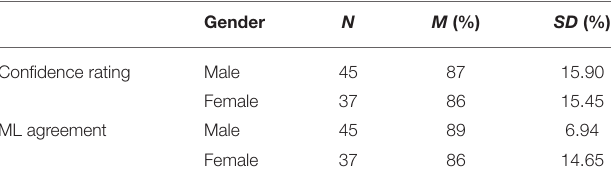
TABLE 3 | Confidence rating (OpenFace) and ML agreement as a function of gender.